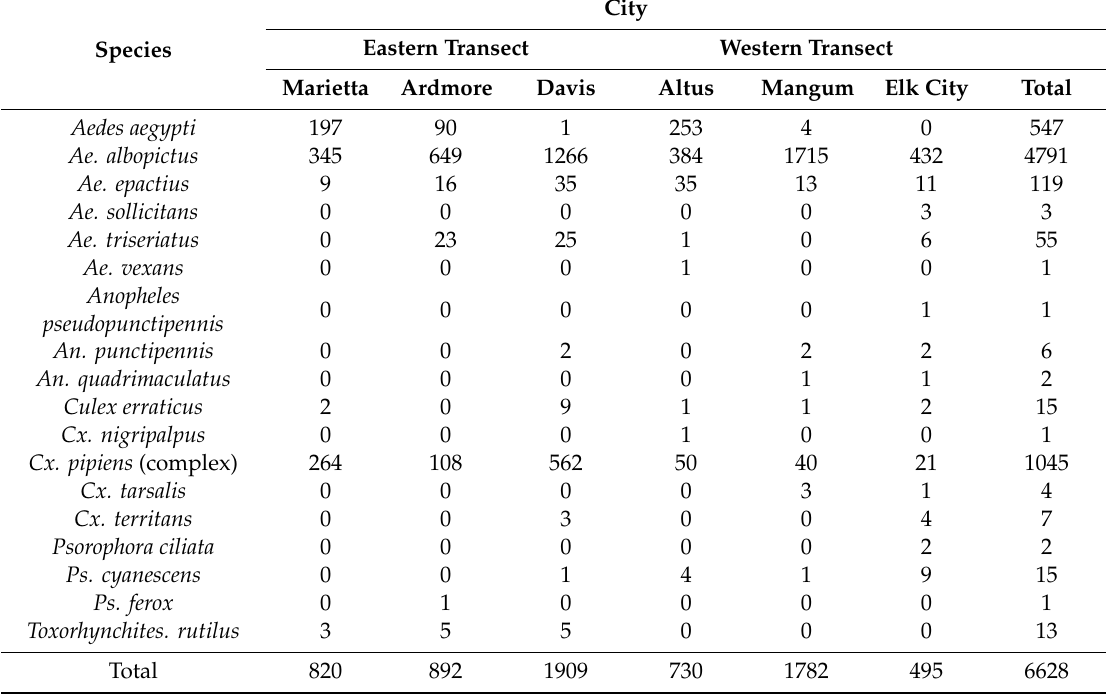
Table 2. Mosquito species collected in six Oklahoma cities using two trapping methods between June and August